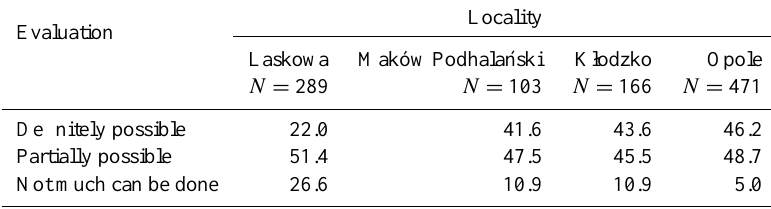
Table 5. Share of the respondents (%) agreeing with different evaluations of the possibility of a decrease in flood losses. Evaluation